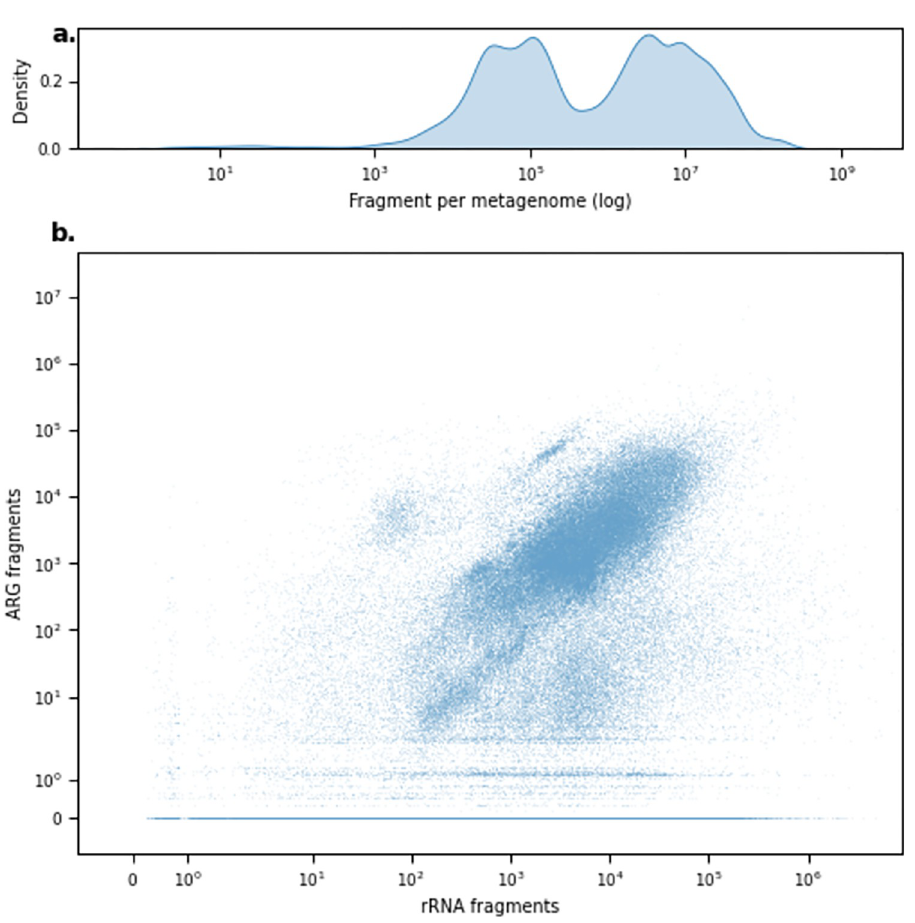
Fig 2. Distribution of available and aligned fragments. (a) Density distribution of available fragments per sample. ( b) The distribution compares the number of fragments mapped to rRNA genes and ARGs. The data underlying this figure can be found at https://doi.org/10.5281/zenodo.6919377.